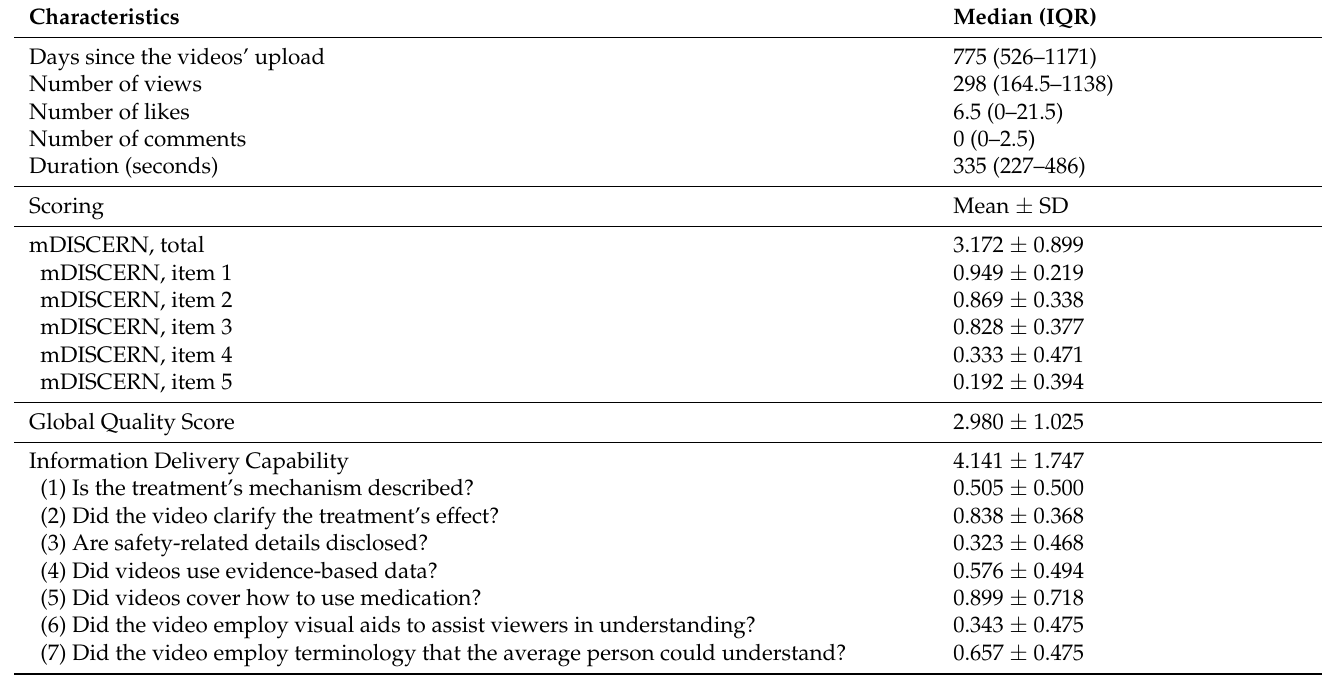
Table 1. Basic characteristics of included videos ( n =